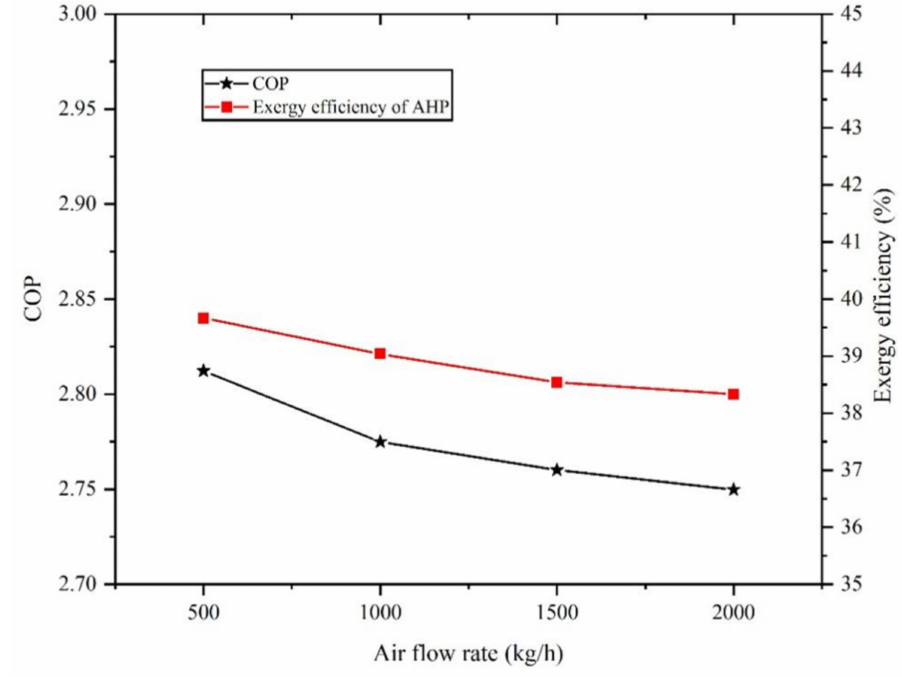
Figure 22. COP and exergy efficiency of the LCPV/T under variable air flow rate.